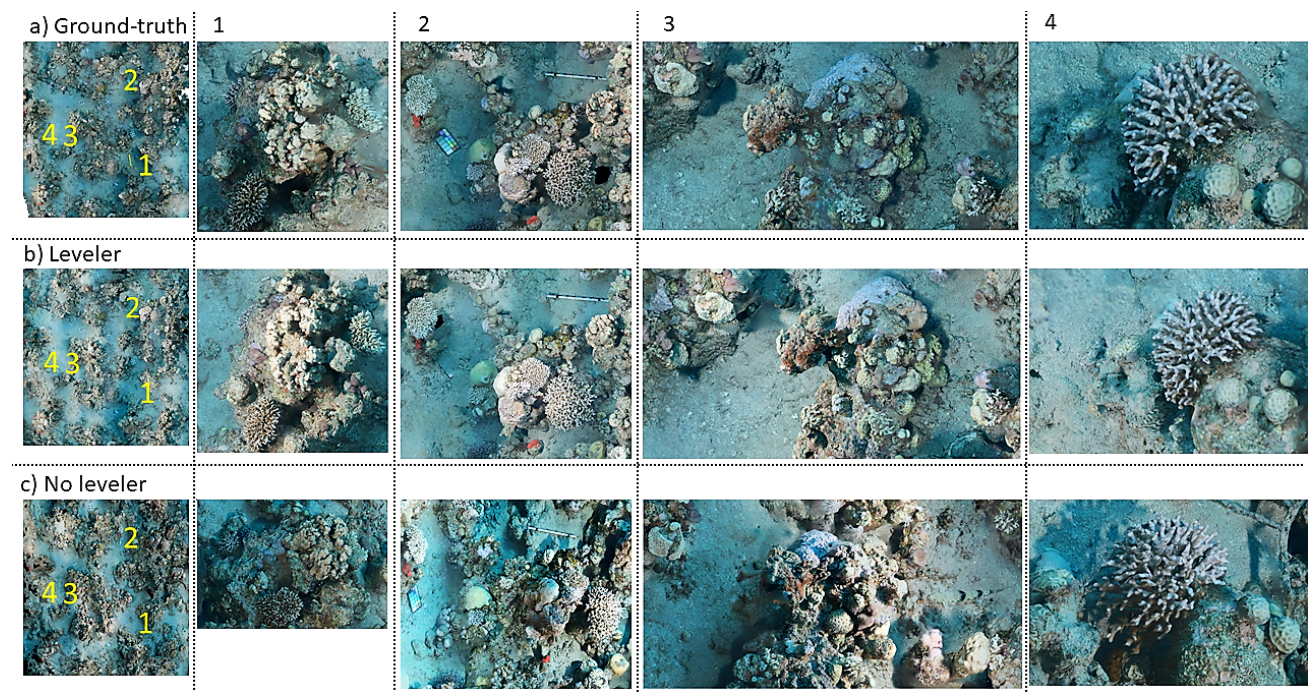
Figure 1. The effect of orthorectification with a leveler on coral topology, prevalence and size: Three photomosaic replicates were generated subsequently. ( a ) Ground-truth (baseline) photomosaic. ( b ) Replicate which was orthorectified using the spirit leveler as a reference. ( c ) No leveler (Naïve) was orthorectified without intervention (3D transformation). The numbers in yellow (left) are close-ups on the